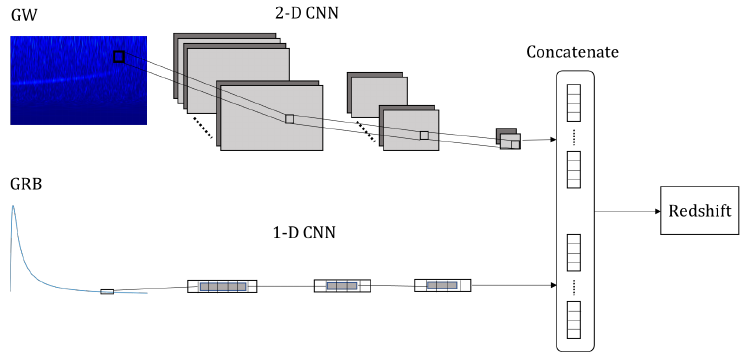
Figure 4. Illustration of the multimodal machine learning model adopted in the analysis to compute redshifts of joint GW and GRB sources. The network reads two different types of data, images, and time series to tackle the regression problem.